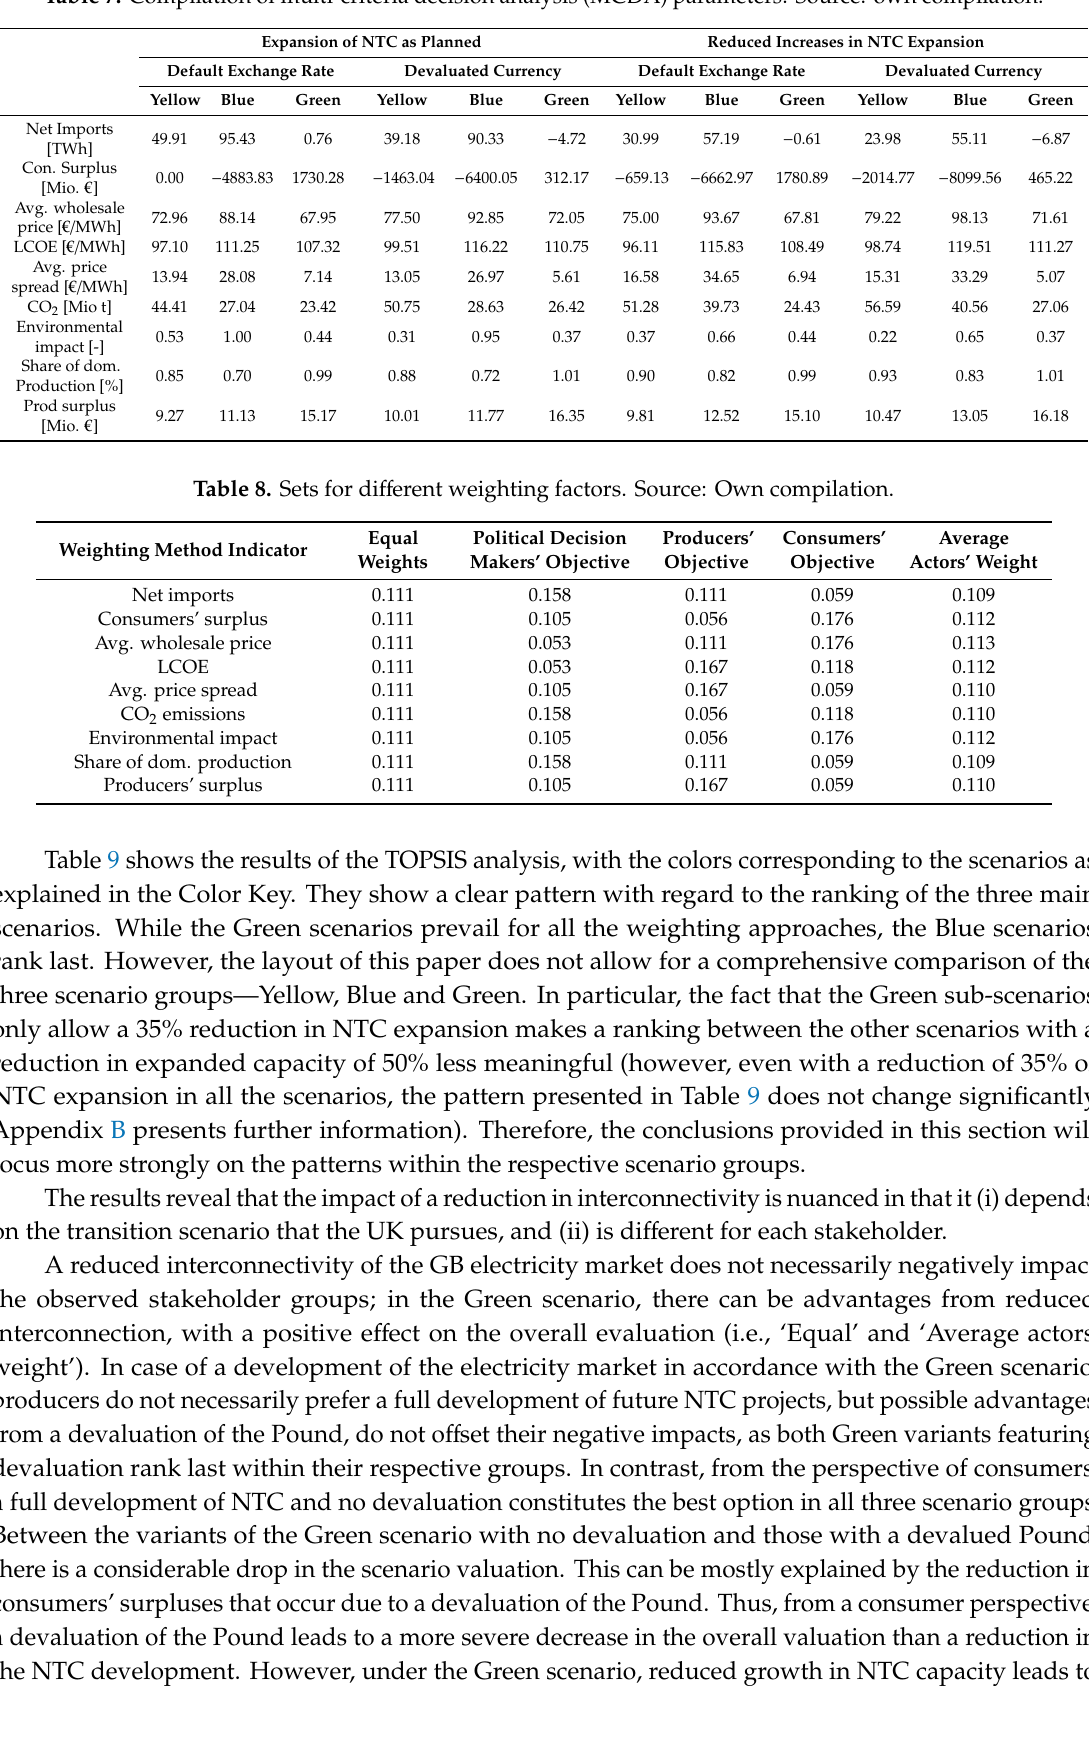
Table 7. Compilation of multi-criteria decision analysis (MCDA) parameters. Source: own compilation.